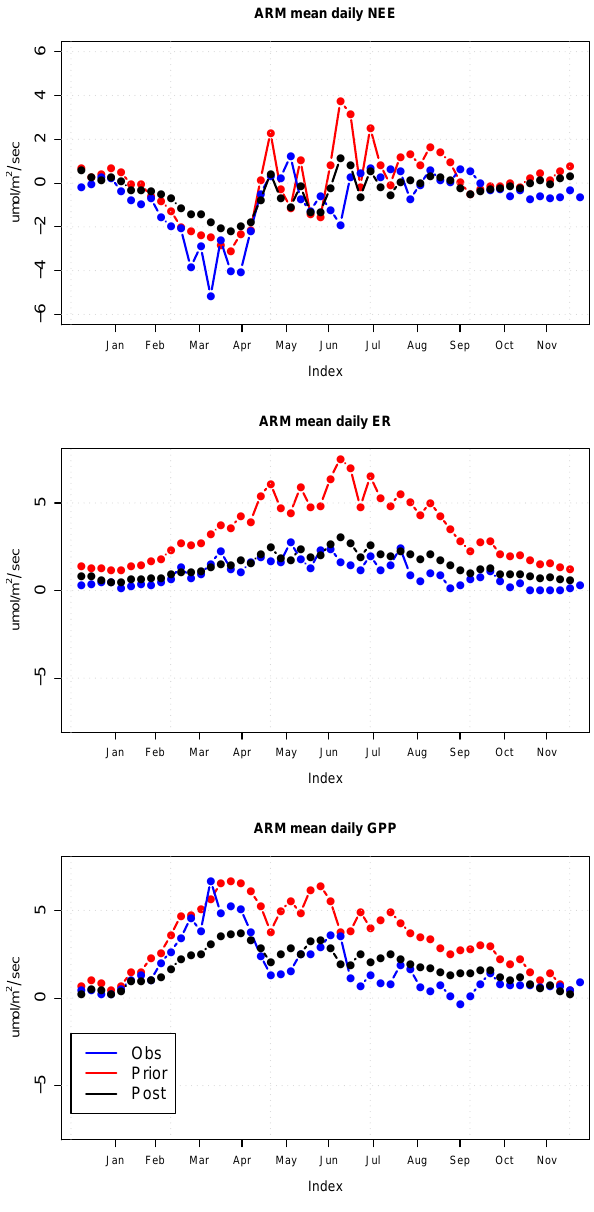
Fig. 11. Comparison of posterior fluxes of GPP, ER, and NEE with Ameriflux Level 4 flux tower data for ARM Site in OK. Pay partic- ular attention to the fact that the y -axes are different